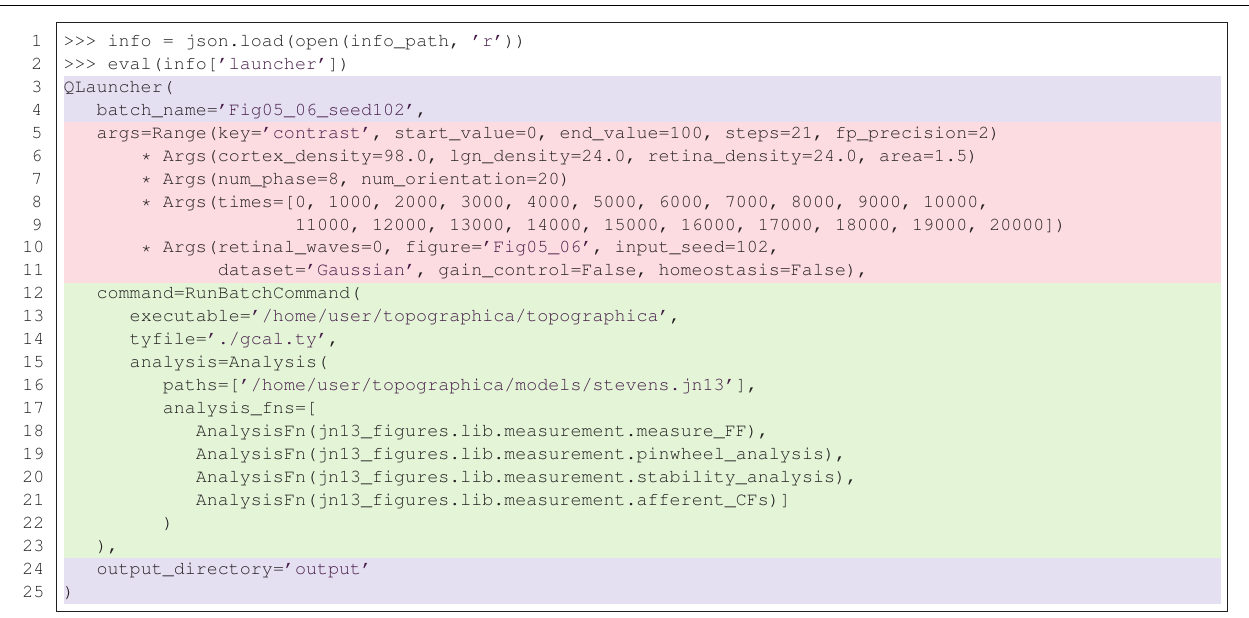
FIGURE 5 | A real example of recreating a launcher from the complete, declarative specification saved to the .info file. The repr (the string representation) of the launcher is shown above, matching the corresponding string saved in the .info file. This example fully specifies 21 Topographica